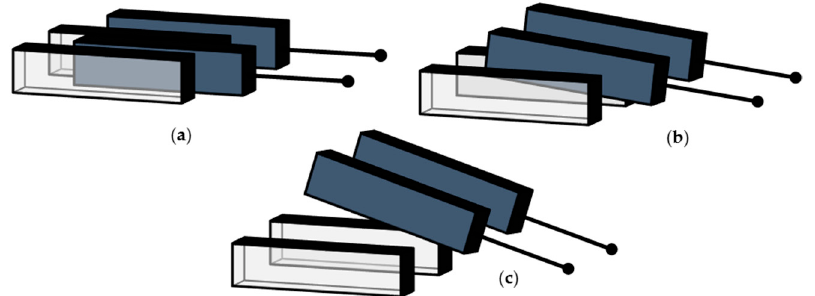
Figure 1. Schematics of stator / rotor configurations at comb fingers, during the torsional motion of a micro-mirror: ( a ) engaged, ( b ) partially engaged, and ( c ) disengaged phases.